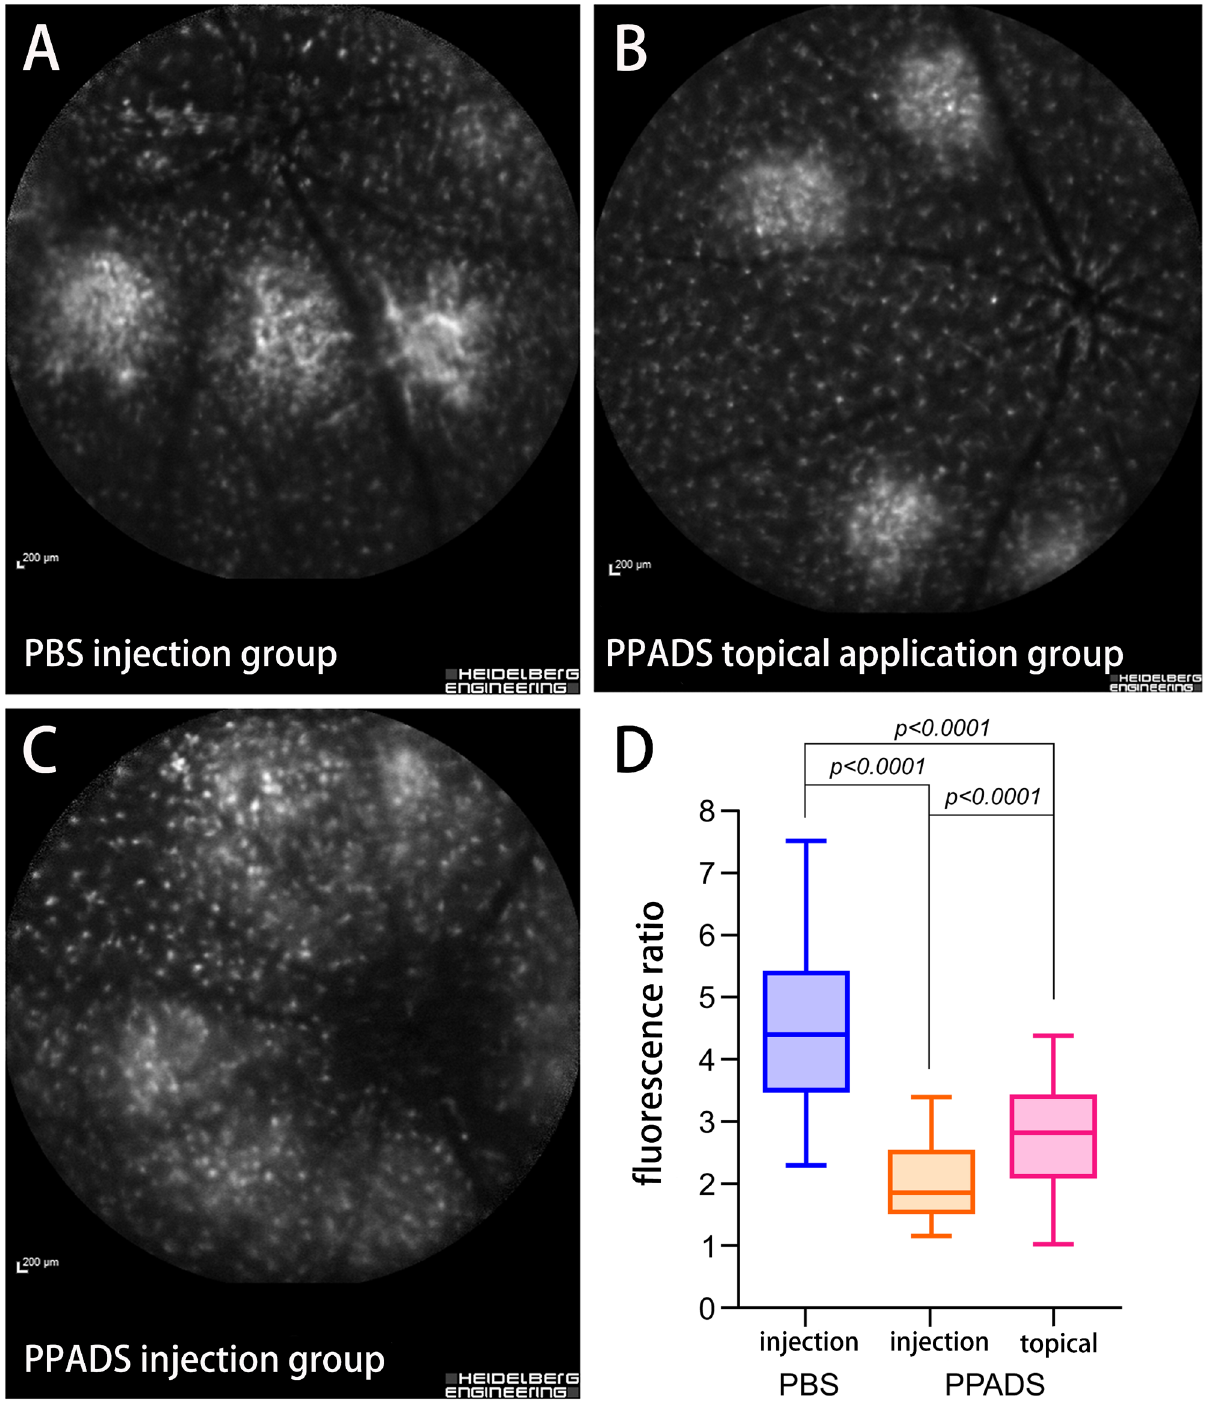
Figure 6. Representative images of GFP fluorescence of microglia in the laser spots in three experimental groups ( A PBS injection group; B PPADS topical application group; C PPADS injection group) taken with the scanning laser ophthalmoscope. Diagram (D) shows results of numerical evaluation of intensity of fluorescence in the laser spots showing amounts of microglial cells that migrated into the laser